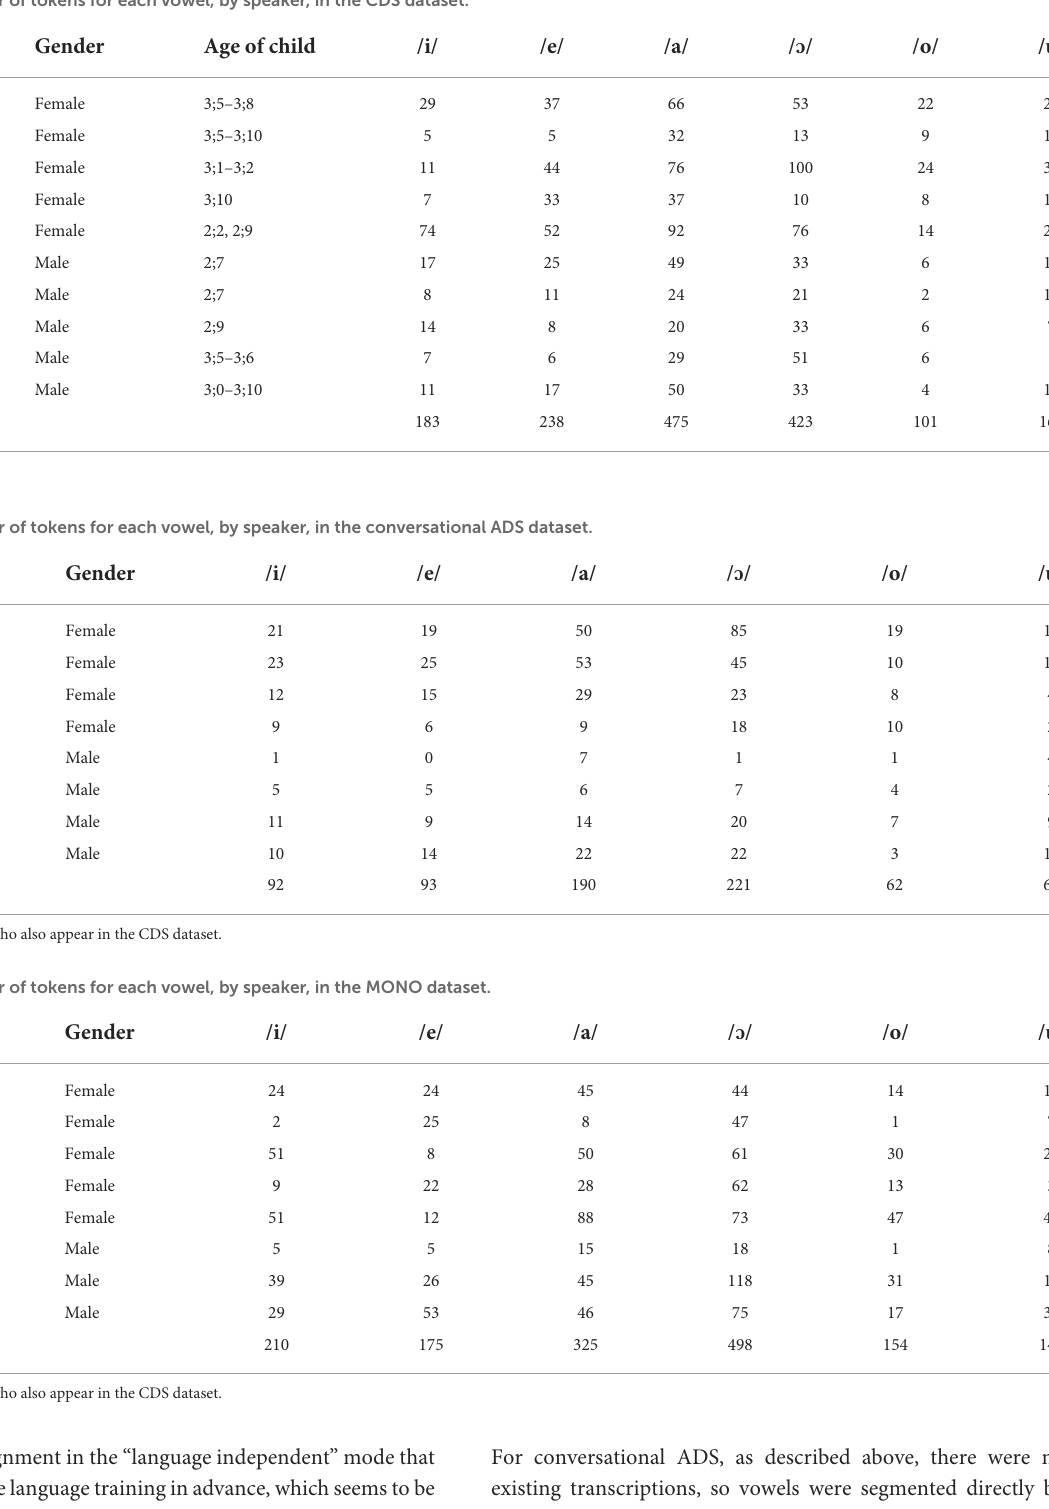
TABLE 1 Number of tokens for each vowel, by speaker, in the CDS dataset.